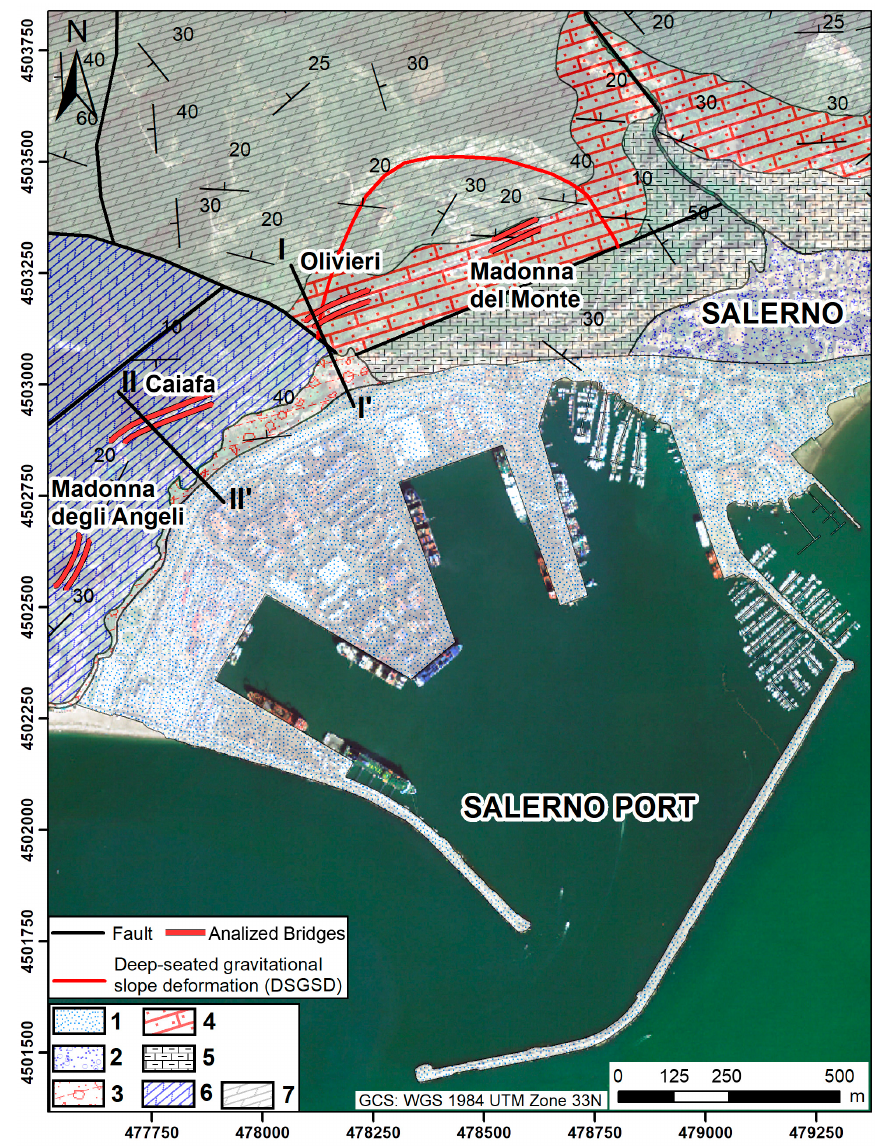
Figure 2. Geological settings: 1. Anthropogenic debris and landfills; 2. gravels and sands with pelitic intercalations; 3. dense to partially cemented clastic and heterometric deposits, sometimes as stratiform bodies, composed of coarse angular and subangular grains; 4. dolomites and limestones, massive or in medium thin layers; 5. marl limestone in thin laminated layers, alternating with tabulated marls and stratified mudstones; 6. well stratified–massive dolomites, in many layers laminated and 7. dolomite in thin and medium layers, alternating with laminated dolomites. This map has been drawn based on the maps available on the website [55].